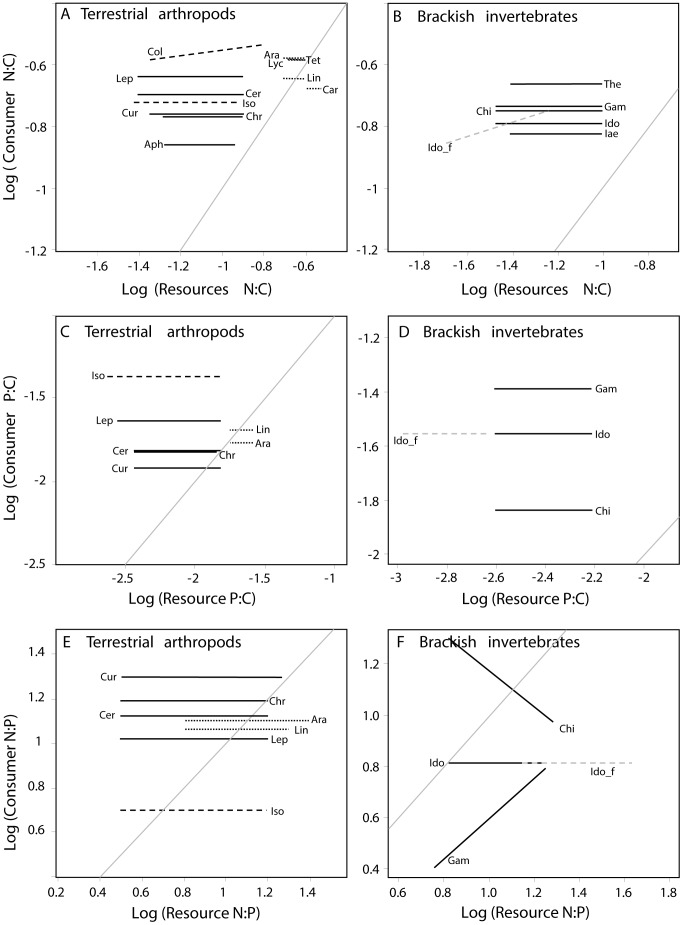
Relationship between consumer and resource N:C (A and B), P:C (C and D), and N:P (E and F) for terrestrial arthropods (A, C, E) and brackish invertebrates (C, D, F).Solid lines indicate herbivores, dashed lines detritivores, and dotted lines predators. The horizontal range corresponds to the data range of the resource. The grey diagonal line represents the 1∶1 relation. Resource: Plants: Col: Collembola, Iso: Isopoda, Lep: Lepidoptera larvae, Cer: Cercopidea, Cur: Curculionidae, Chr: Chrysomelidae, Aph: Aphids; Resource: adult Chironomidae: Ara: Araneidae, Lin: Linyphiidae, Tet: Tetragnathidae, Lyc: Lycosidae; Resource: Collembola: Car: Carabidae; Resource: Epiphytes: The: Theodoxus fluviatilis, Chi: Chironomidae larvae, Id: Idotea spp, Gam: Gammarus spp, Ia: Jaera albifrons;
Resource: Fucus: Id_f: Idotea spp.